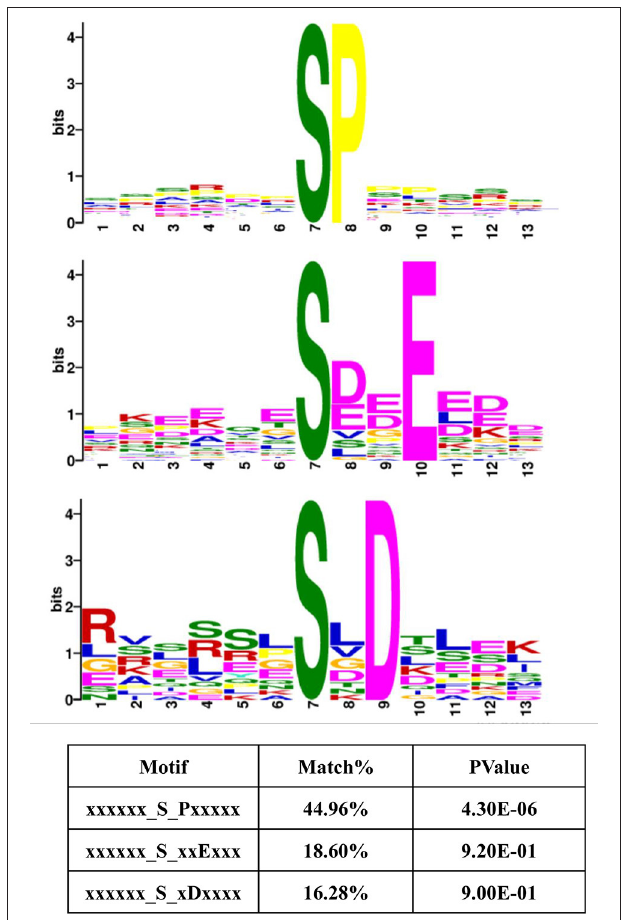
FIGURE 7 | Motif analysis, based on the phosphorylated proteins that were positively associated with amino acid signals. Peptide sequences, featuring 13 amino acids, centered on the phosphorylated sites that were positively associated with amino acid signals were input into MoMo software